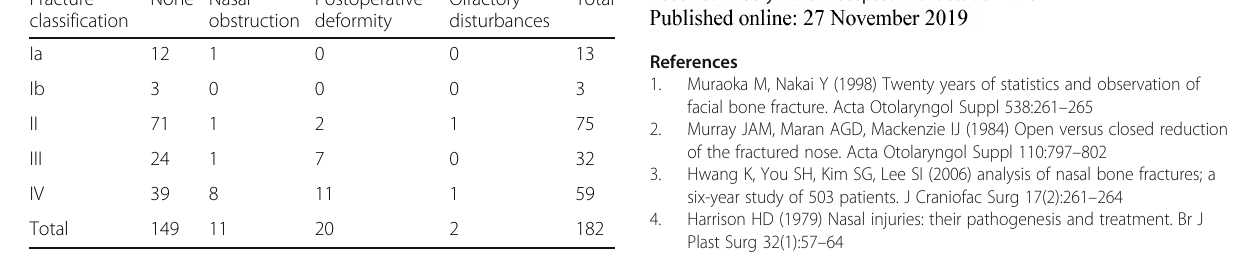
None Nasal Postoperative obstruction deformity